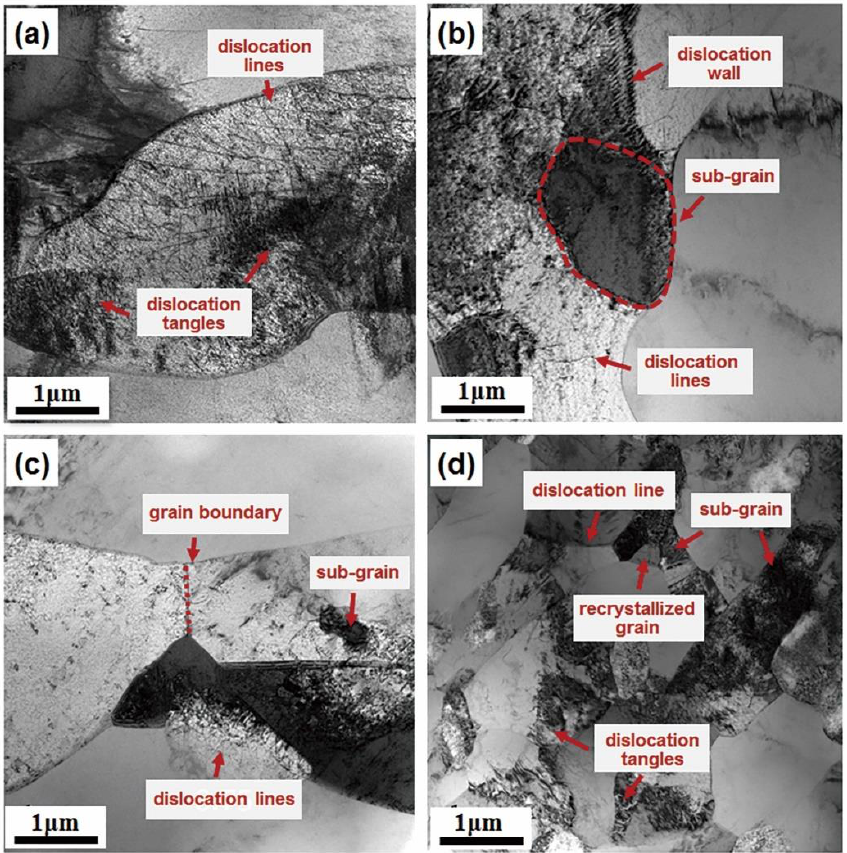
Figure 7. TEM micrographs for TB18 alloy deformed in β phase zone: ( a ) 850 °C/0.001 s − 1 , ( b ) 850 °C/0.01 s − 1 , ( c ) 880 °C/0.01 s − 1 , ( d ) 880 °C/0.1 s − 1 .